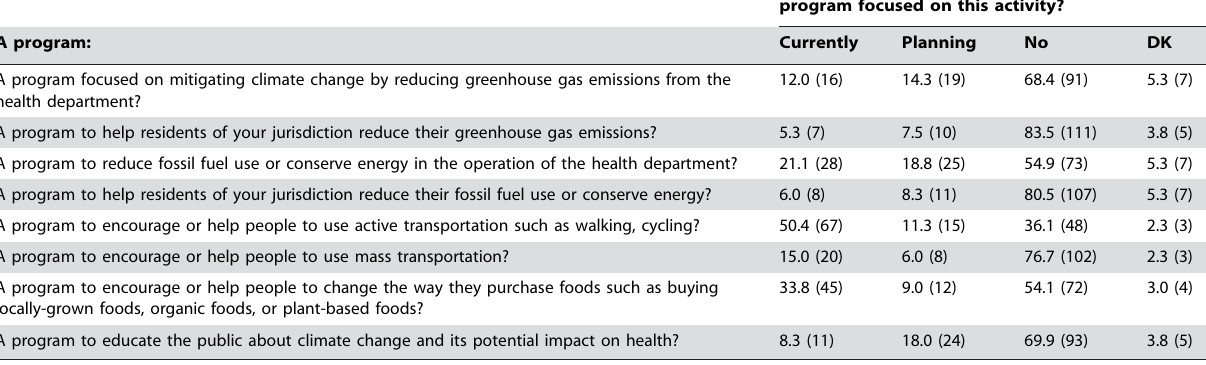
Table 6. Climate change mitigation activities of local health